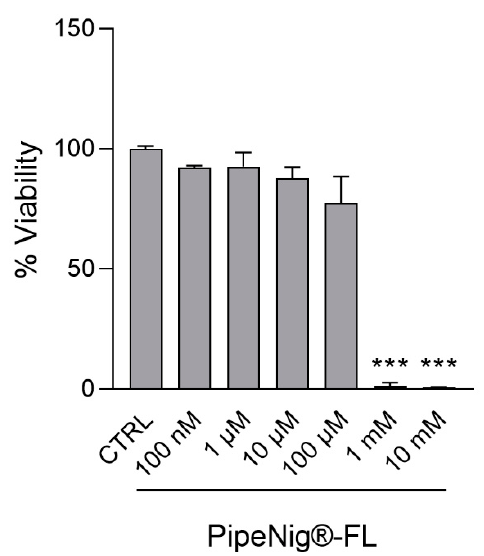
Figure 2. PipeNig ® -FL affects 3T3-L1 cell viability only at high (millimolar) concentrations. 3T3-L1 cells were induced to differentiate into adipocytes for 9 days and treated with increasing concentrations of PipeNig ® -FL for the entire differentiation period. The bar graph summarizes cell viability based on ATP content. Data in percentage referred to control condition are represented as the mean ± standard error of the mean (SEM) of three independent experiments. *** p < 0.001 vs. control.